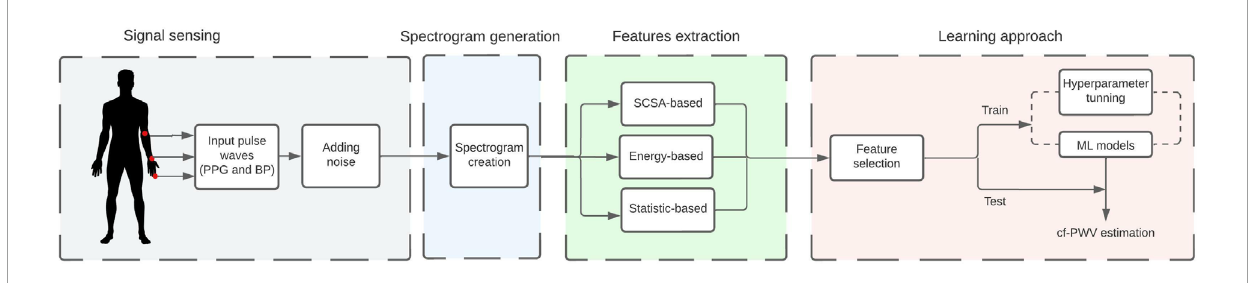
FIGURE 1 Schematic illustration of the estimation pipeline of the carotid-to-femoral pulse wave velocity based on pulse wave images. PPG indicates the photoplethysmography signals, BP the blood pressure signals and ML indicates machine learning models.